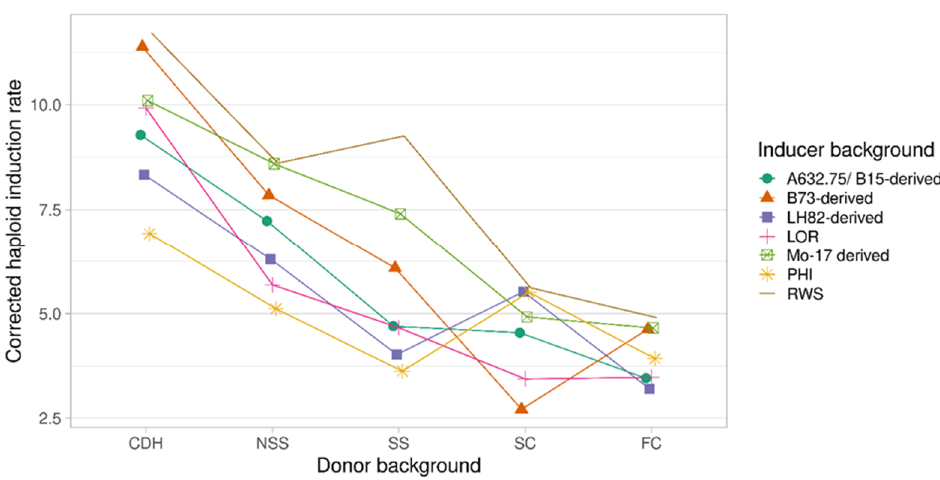
Figure 1. The interaction plot between the donor and inducer backgrounds. Abbreviations: CDH —